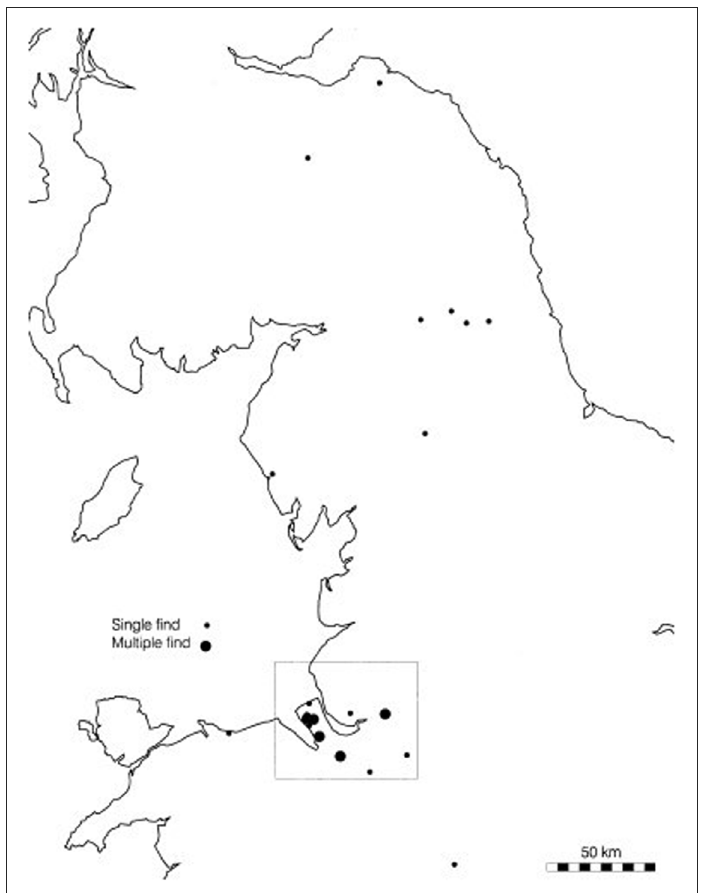
Figure 6: Distribution of Wirral type brooch in Britain (Philpott 1999: 280. Reproduced with